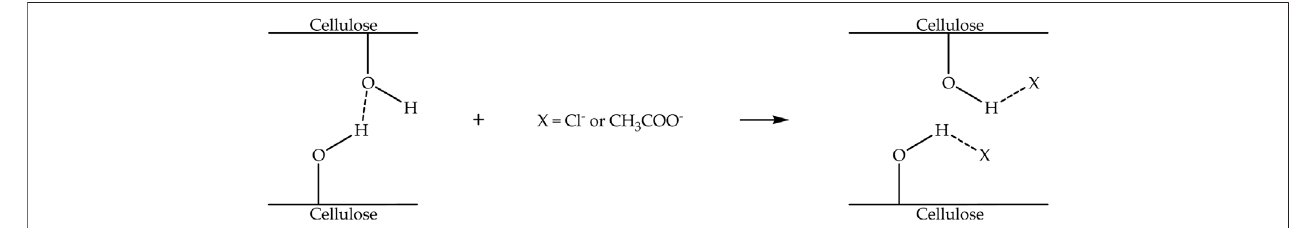
FIGURE 5 | Mechanism of the dissolution process of cellulose with chloride or acetate anion-based ionic liquids.